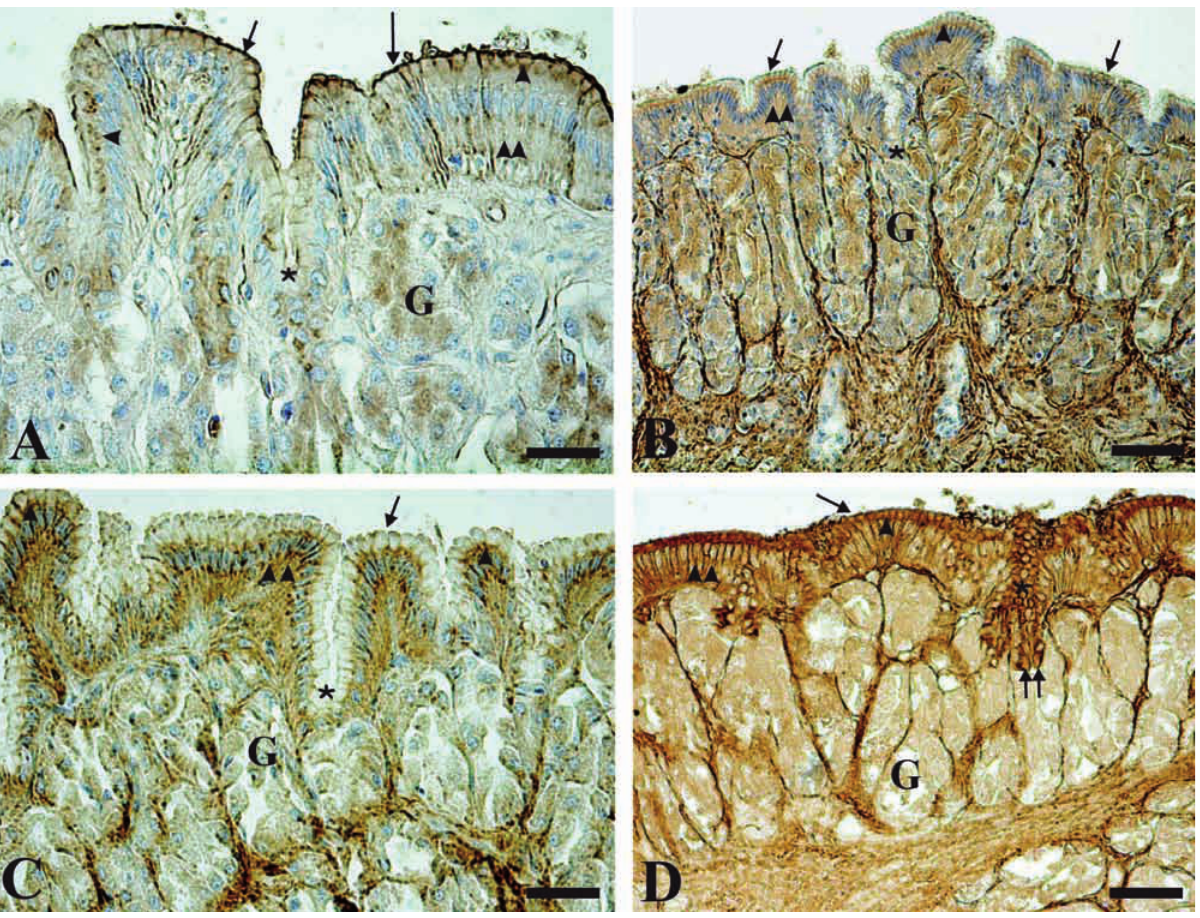
Fig . 6. – Koh-sialidase/WGa (a), GSa i-B (B), GSa ii (c), and uea i (D) labelling of the gastric mucosa of Halobatrachus didactylus . 4 a, WGa binding sites are present in the luminal surface, supra-nuclear and sub-nuclear cytoplasm of surface epithelial cells as well as in the sub-nuclear cytoplasm of the pit cells and the gastric glands. Scale bar: 22 μm. B, GSa i-B shows moderate staining in a thin supra-nuclear 4 cytoplasm of epithelial columnar cells and gastric glands, whereas it gives a faintly visible reaction in the sub-nuclear cytoplasm of surface epithelial cells and pit cells. Scale bar: 46 μm. c, GSa ii moderately stains the supra-nuclear cytoplasm and weakly stains the sub-nuclear cytoplasm of the surface epithelial cells. Scale bar: 30 μm. D, uea i strongly stains the luminal coat of columnar epithelial cells and the neck cells, moderately stains the apical and supra-nuclear zones of the surface epithelial cells, and weakly stains the sub-nuclear cytoplasm of lining epithelial cells and pit cells. Scale bar: 46 μm. G, gastric gland; arrow, surface epithelial cells; arrowhead, supra-nuclear zone; double arrow, neck cells; double arrowhead, sub-nuclear zone; asterisk, pit